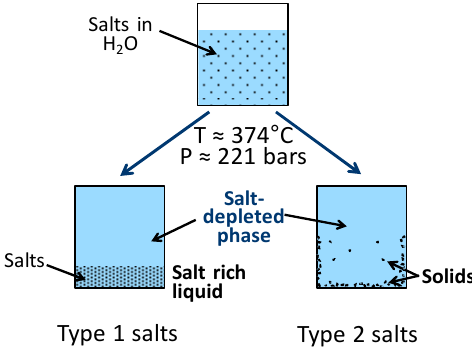
Figure5. Figure 5. Schematic representation of the behavior of Type 1 and 2 salts at high pressure and temperature.